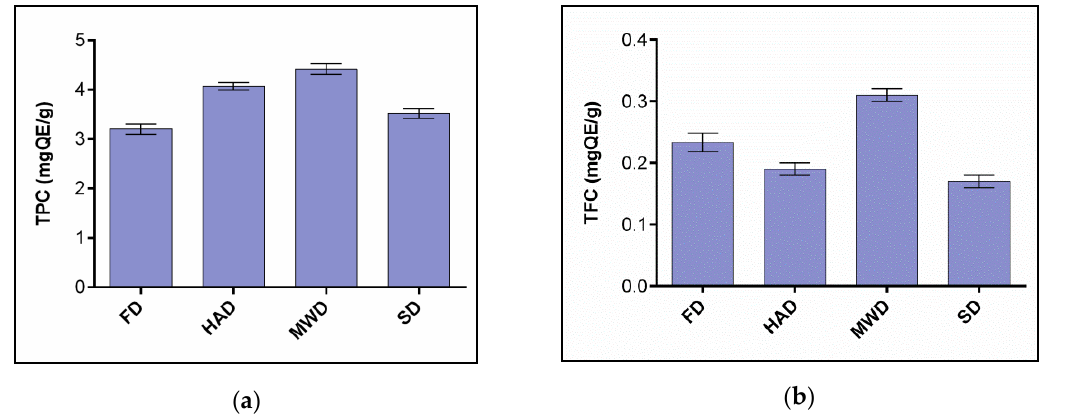
Figure 4. The content of total phenols ( a ) and total flavonoids ( b ) in the dry fruit bodies of Pleurotus ostreatus after in vitro digestion. FD—freeze drying; HAD—hot air drying; MWD—microwave drying; SD—sun drying.